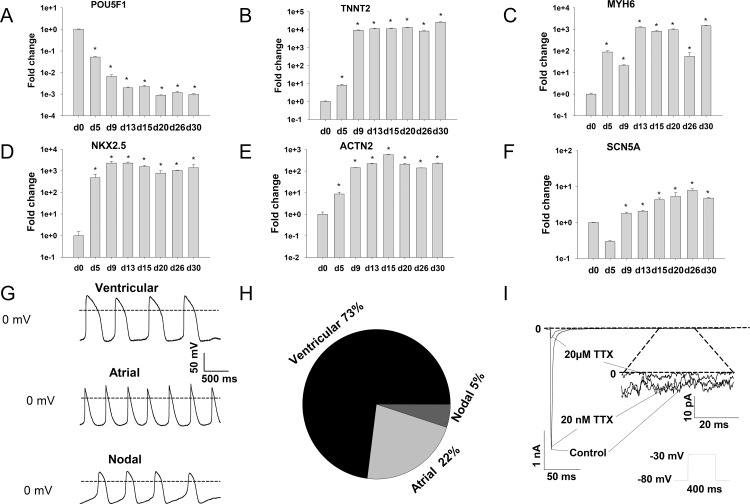
Characterizations of hiPSC-CMs.qPCR analysis was carried out to assess the expression of the pluripotency gene POU5F (A) and the cardiac genes TNNT2 (B), MYH6 (C), NKX2.5 (D) and ACTN2 (E) as well as the sodium channel gene SCN5A (F) at different times after onset of differentiation. Spontaneous APs were recorded in current-clamp mode without injection of current. Three forms of AP were observed (G-H). (I) Representative cardiac INa, resistant to 20 nM TTX but sensitive to 20 μM TTX, was measured with the protocol shown as an inset at the bottom. The late INa was shown from 200 ms to 250 ms (indicated by dotted line) with different scale (inset). Values given are mean ± SEM. n = 4/2 (technical replicates/biological replicates). *, p<0.05 vs. d0.